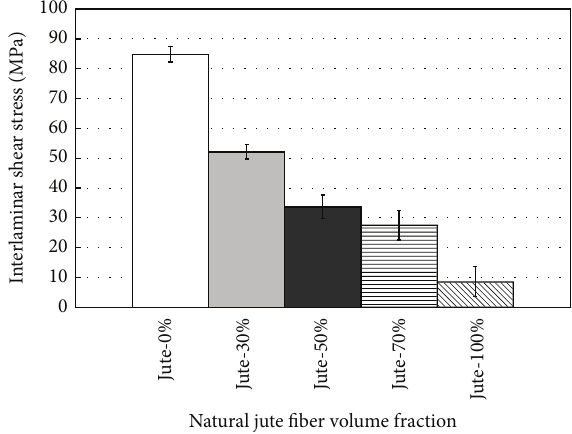
Figure 7: Interlaminar shear stress of HGJFRP composite